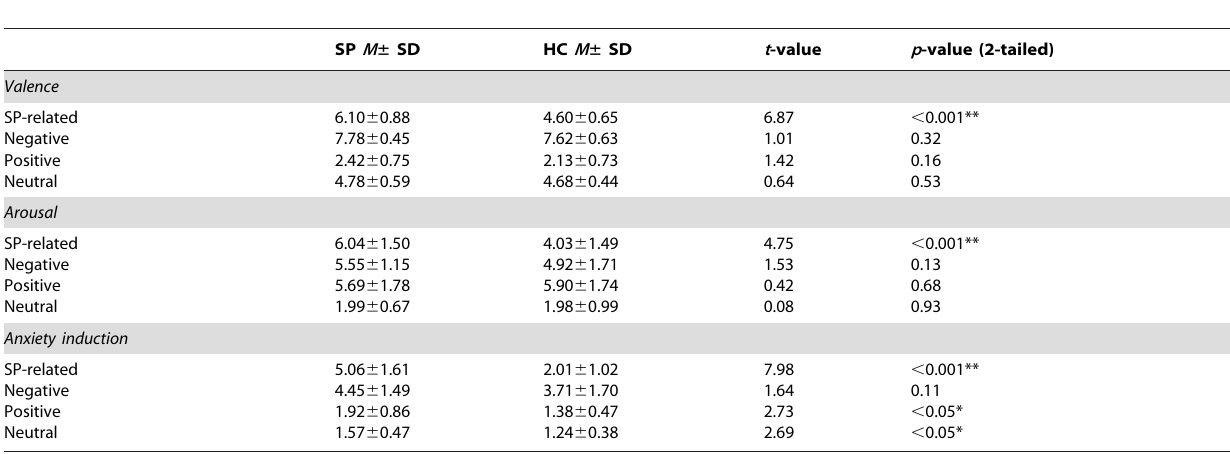
Table 2. Results of post-scanning ratings of SP-related, negative, positive, and neutral words for valence, arousal, and anxiety induction by social phobia patients (SP) and healthy controls (HC).